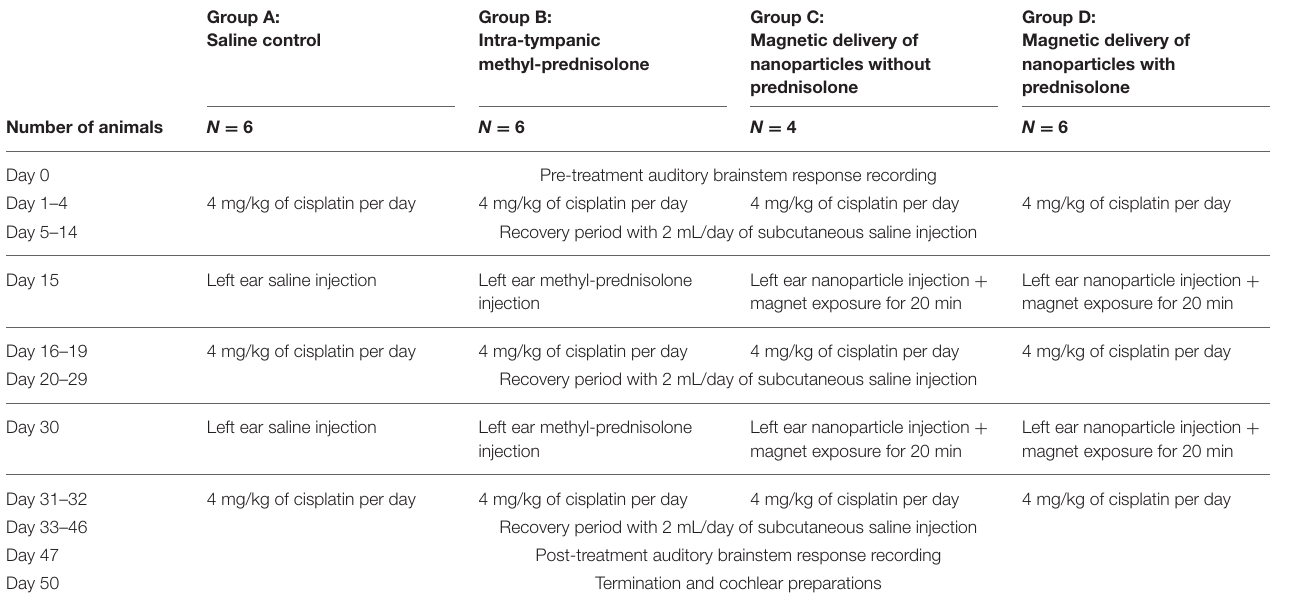
TABLE 1 | Animal groups and schedule for our cisplatin and ear treatment study.